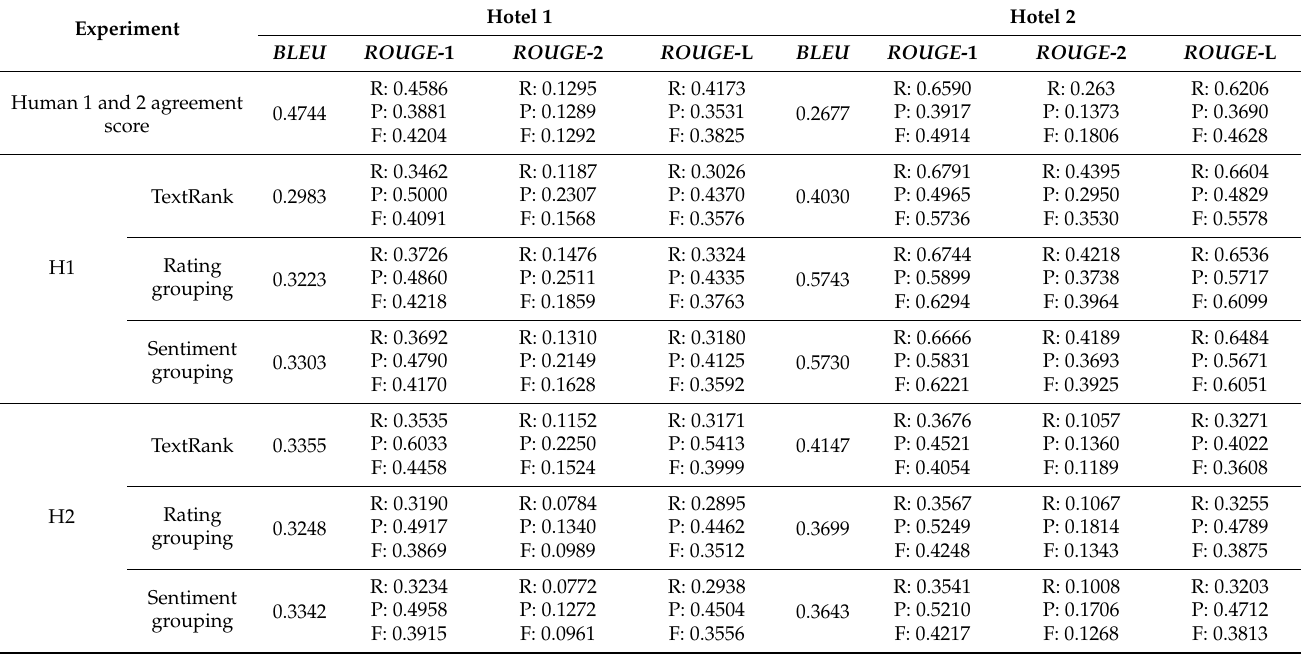
Table 9. Performance evaluation of summarizing both hotels’ reviews with TextRank, and the proposed method with five-class polarity grouping by the two suggested approaches: rating score and the DL-based sentiment against human-generated summaries 1 and 2 (H1 and H2).